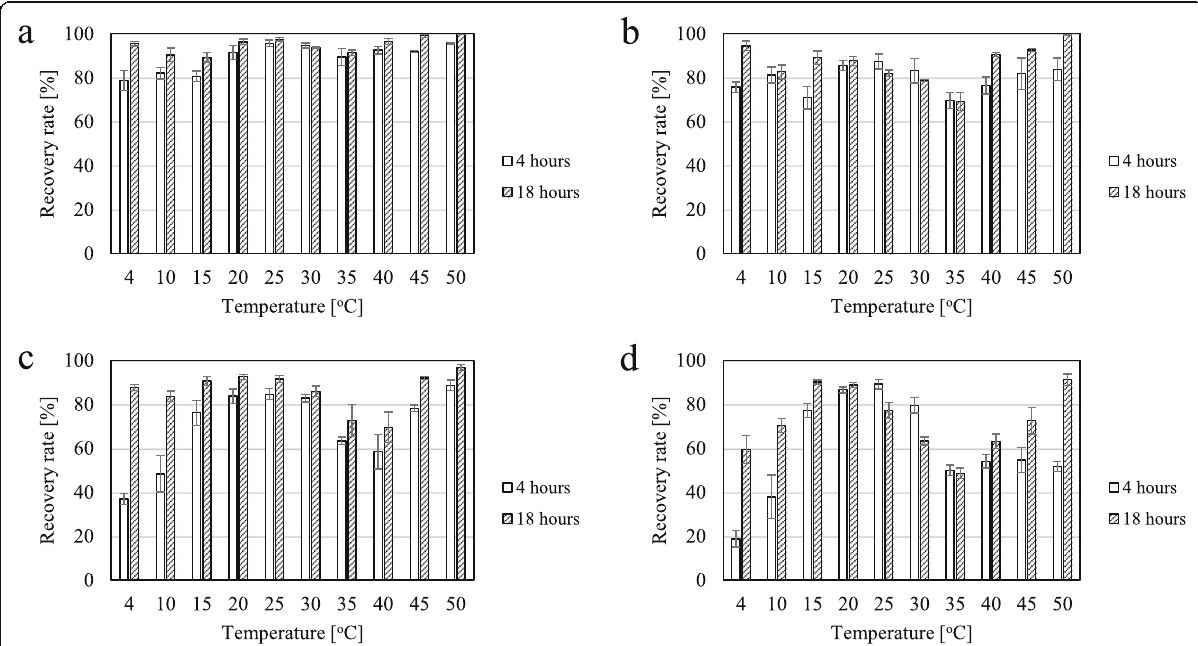
Fig. 2 Effect of temperature on gravity sedimentation of D. salina cells. a Recovery rate of carotenoid-accumulating cells cultured at 12.5% salinity. b Recovery rate of normal cells cultured at 12.5% salinity. c Recovery rate of carotenoid-accumulating cells cultured at 17.5% salinity. d Recovery rate of normal cells cultured at 17.5% salinity. The recovery rate of both cells in the gravity sedimentation was obtained after incubation for 4 h (white bar) and 18 h (hatched bars) at a given temperature. The recovery rate for each sample was determined in triplicate. All of the error bars represent the standard deviation of the